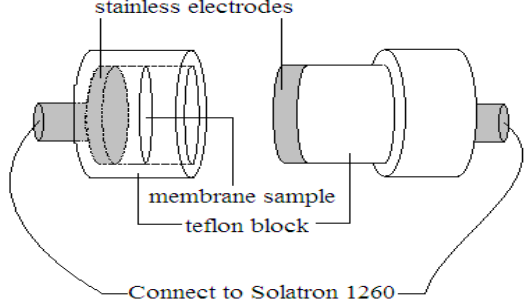
Figure 2. Schematic diagram of the proton conductivity cell.